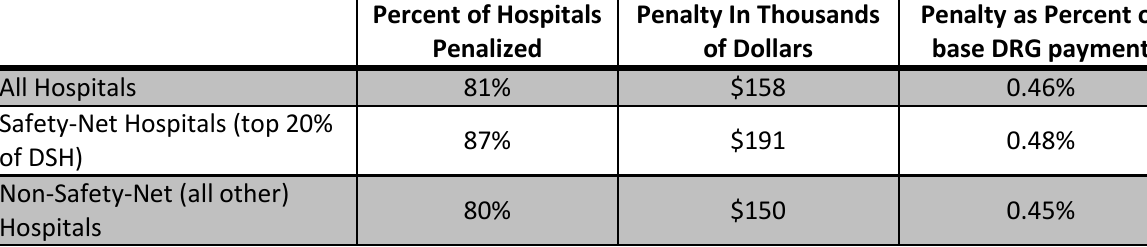
Percent of Hospitals Penalty In Thousands Penalty as Percent of Penalized of Dollars base DRG payment 87% $191 0.48% 80% $150 0.45%